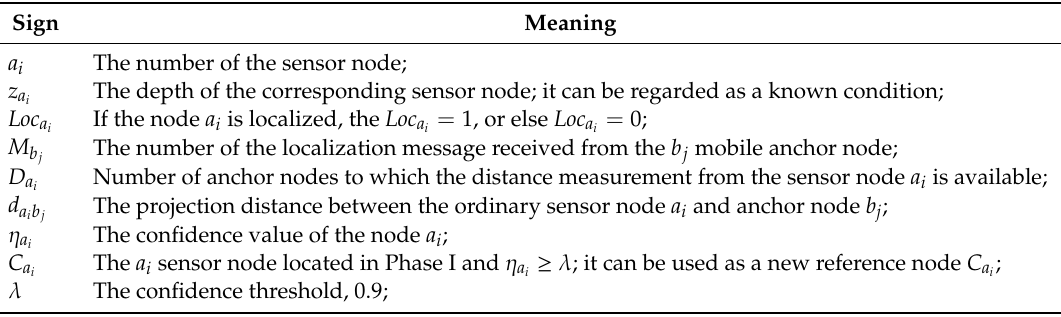
Table 3. Definition of related